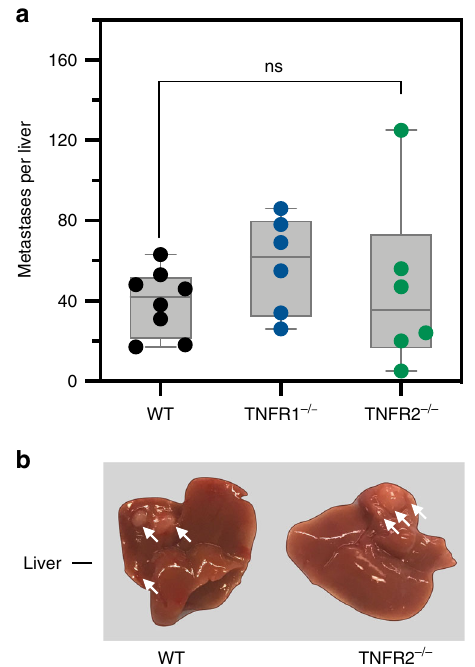
Fig. 1 Loss of TNFR2 expression does not reduce LM in male mice. Male Bl6 mice were inoculated with 5 × 10 4 MC-38 cells via the intrasplenic/ portal route. Liver metastases were enumerated 20 days later. Shown in a are pooled data of two experiments and in b representative livers from tumor-injected mice ( n = 8 for WT, n = 6 for TNFR1 − / − , and n = 6 for TNFR2 − / − mice; horizontal bars denote median values). NS, not signi fi cant as determined by the Mann – Whitney test. Box and whiskers graphs: the box extends from the 25th to 75th percentiles, the middle line denotes the median and the whiskers extends from the minimum to the maximum